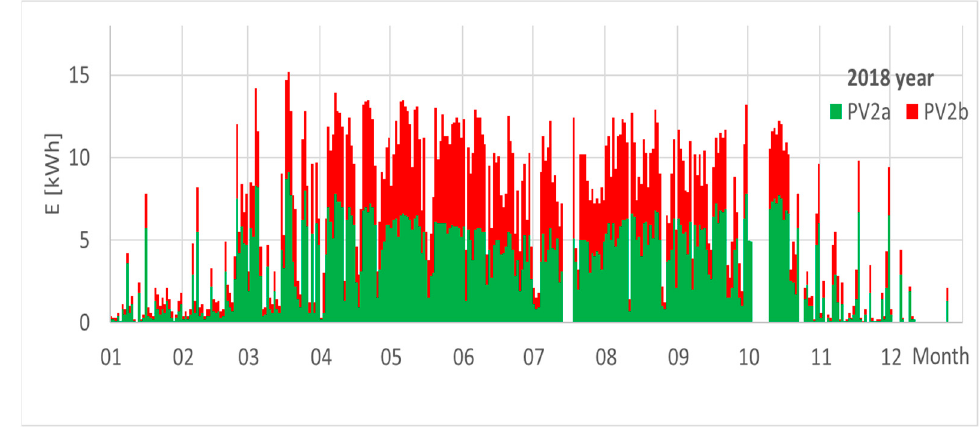
Figure 16. Daily energy generation by PV1 section in 2018 (own measurement data).